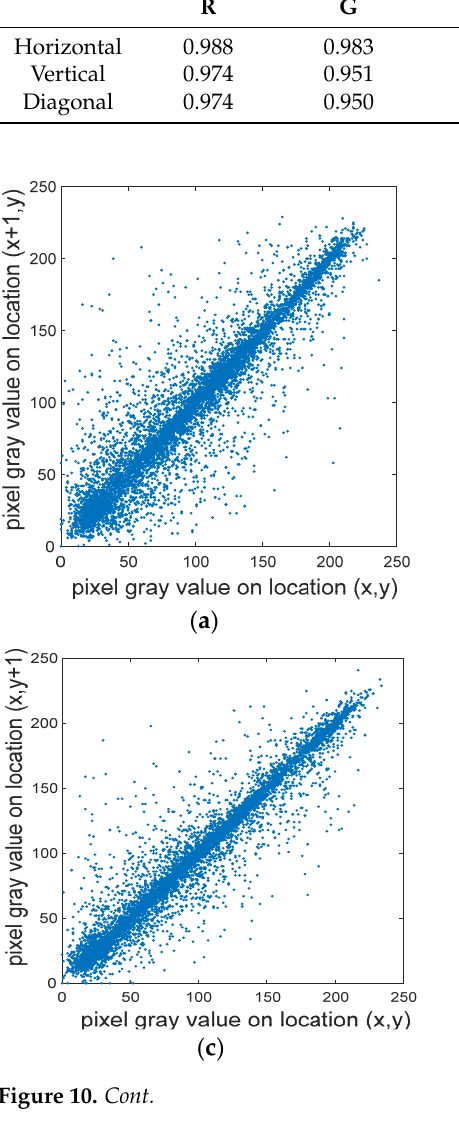
( f ) Figure 10. The level of adjacent ‐ pixel correlation. ( a ) Lena plaintext; ( b ) Lena ciphertext horizontal correlation; ( c ) Lena plaintext vertical correlation; ( d ) Lena clear text vertical correlation; ( e ) Lena plaintext diagonal correlation; ( f ) Lena plaintext diagonal correlation. Table 2. Correlation between adjacent pixels of plaintext and ciphertext images.